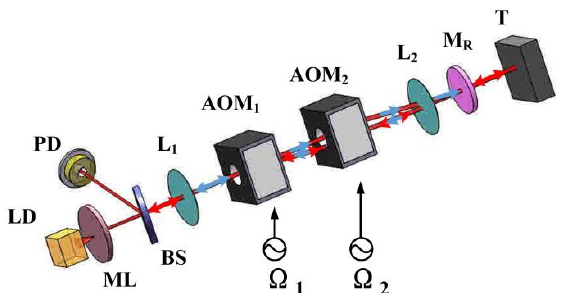
Figure 5. Configuration of the quasi-common-path laser feedback interferometer. LD: laser diode; ML: microchip Nd: YAG laser; BS: beam splitter; PD: photon detector; L 1 , L 2 : lens; AOM 1 , AOM 2 : acousto-optic modulators; M R : reference mirror; T: target.